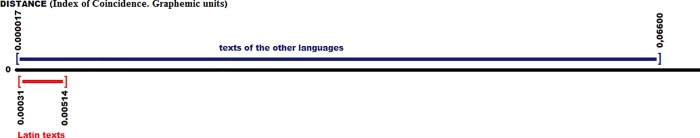
Index of Coincidence of the texts in Latin (graphemic units) (red) versus the rest of the texts (blue).